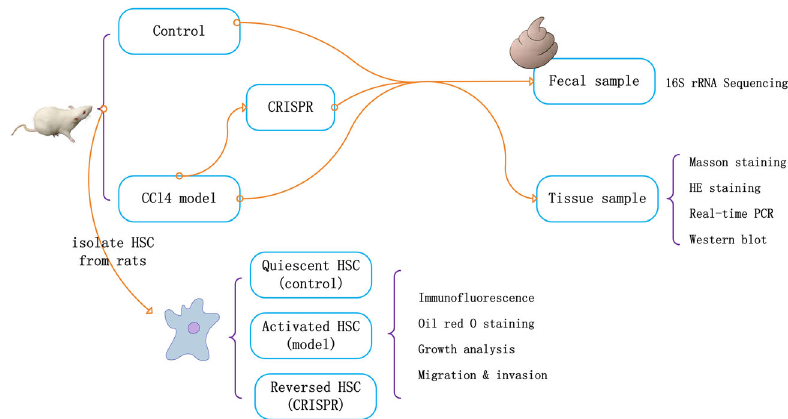
Fig. 7 Study design. CCl 4 -induced fi brotic-liver rats (model group) were injected with lentivirus vectors expressing RSPO4-CRISPR (CRISPR group), with healthy rats served as the control. Fecal samples were collected and examined by 16 S rRNA sequencing. Tissue samples were analyzed by Masson staining, HE staining, PCR, and Western blot, respectively. Activated HSCs isolated from the CCl 4 -induced liver- fi brotic rats were transfected with lentivirus vector expressing RSPO4-CRISPR, with cells isolated from normal rats served as the control. HSC activation status was tested by immuno fl uorescence, Oil red O staining, Transwell assay,